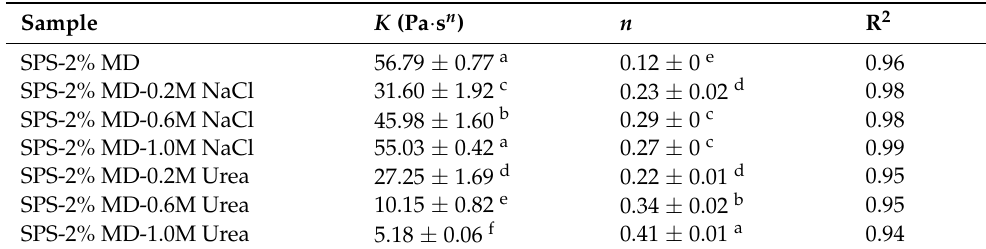
Table 4. Dynamic storage ( G (cid:48) ) modulus parameters of sweet potato starch (SPS) gels with 2% ( w / w ) maltodextrin (SPS-2% MD) under different concentrations of urea and